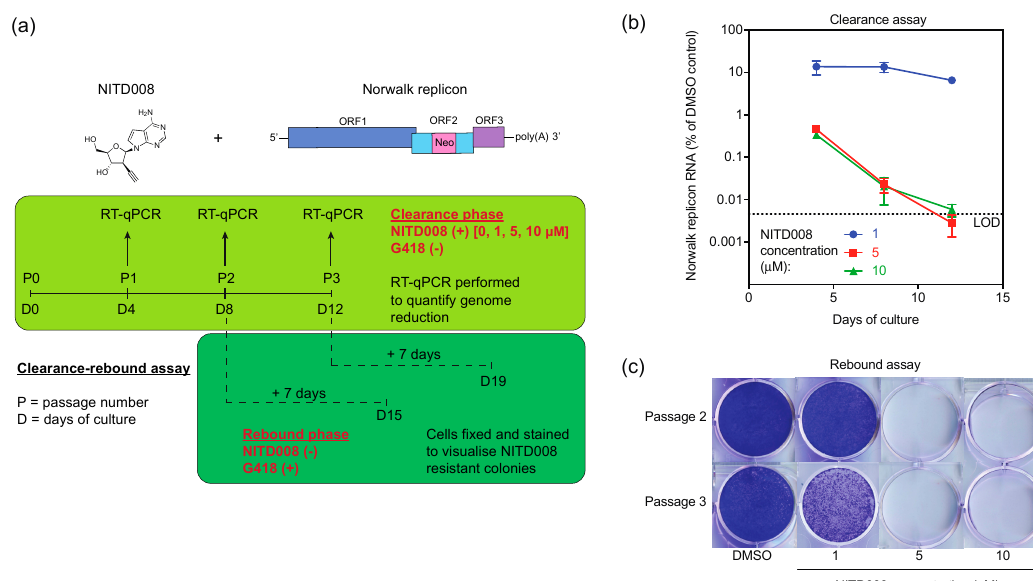
Figure 4. NITD008 effectively clears the Norwalk replicon from replicon-bearing cells. ( A ) Schematic overview of the clearance-rebound assays performed against the Norwalk replicon. The light green panel represents the clearance phase in which replicon-bearing cells were passaged every 4 days in the presence of DMSO or NITD008 at 1, 5, and 10 µ M (~ 5, 25, 50 × the EC 50 value). The dark green panel represents the rebound phase in which NITD008 is removed from the media and G418 is used to selected for replicon-bearing cells. ( B ) Clearance of the Norwalk replicon from cells was determined by RT-qPCR. Norwalk replicon levels following NITD008 treatment at every passage are plotted relative to the corresponding DMSO controls. The dotted line represents the qPCR limit of detection. ( C ) Rebound of the Norwalk replicon was assessed by performing colony formation assays on cells passaged in the presence of NITD008 for either 8 or 12 days. Colonies were fixed and stained with crystal violet before visualization. Triplicate data from at least two independent experiments are presented for each panel. Error bars represent the mean ± standard deviations.